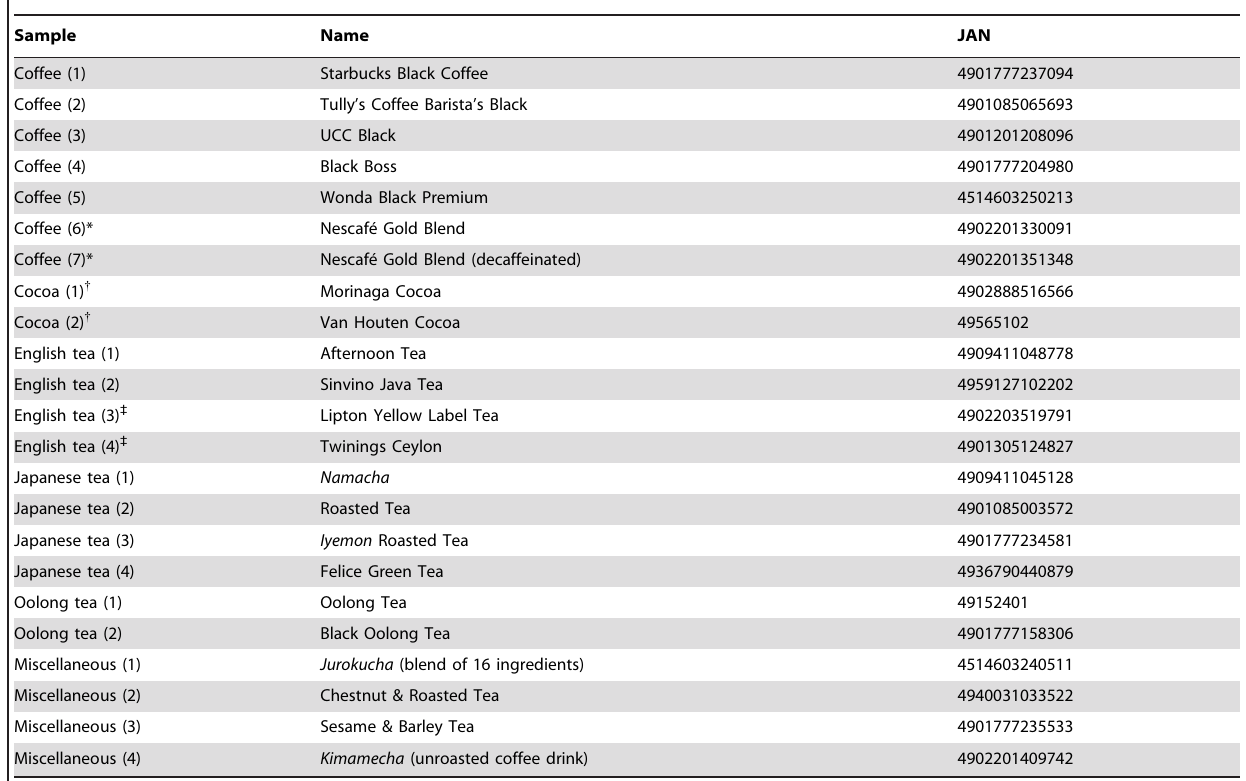
Table 1. Beverage samples tested in Figure